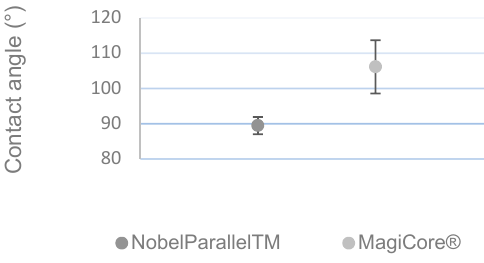
Figure 3. Contact angle measurement (n = 5 ± SD).